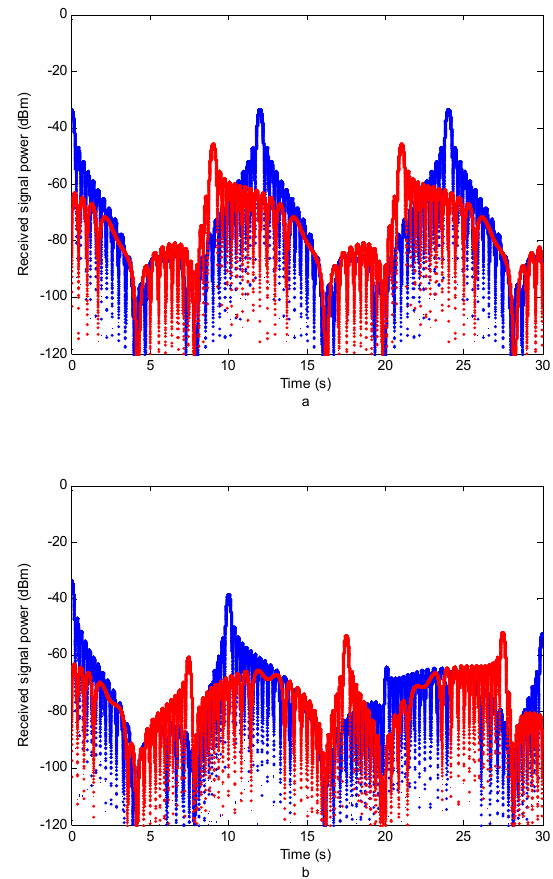
Figure 4. The received signal power comparison at different initial offset angles: ( a ) received signal power at the third-row parameters in Table 1; ( b ) received signal power at the fourth-row parameters in Table 1.